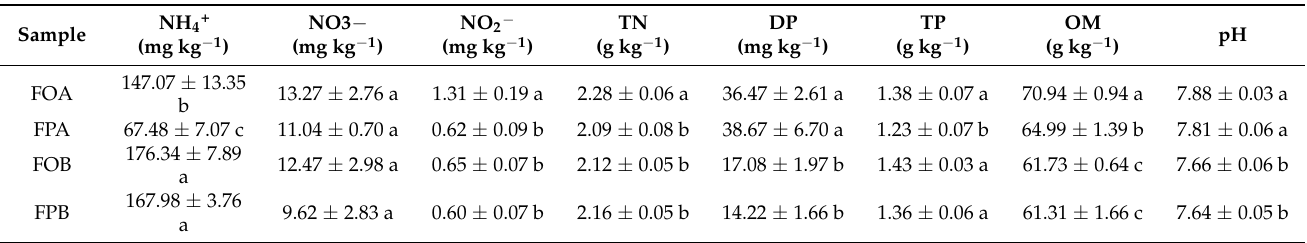
Table 1. Physicochemical factors of pond sediments before and after culture in different culture modes.